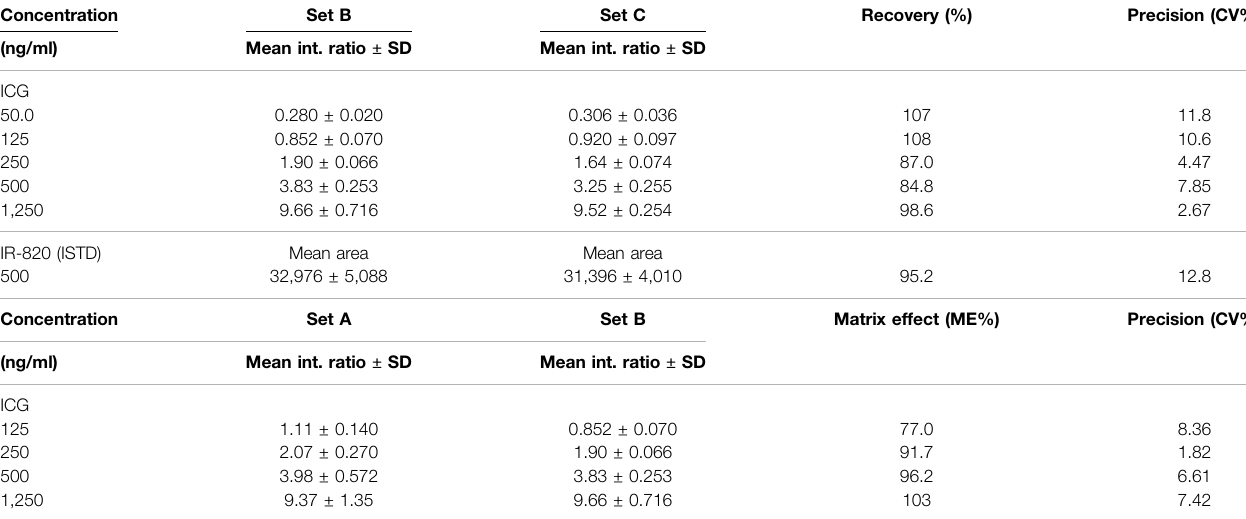
TABLE 2 | Extraction recovery and matrix effect of ICG in murine liver tissue samples.